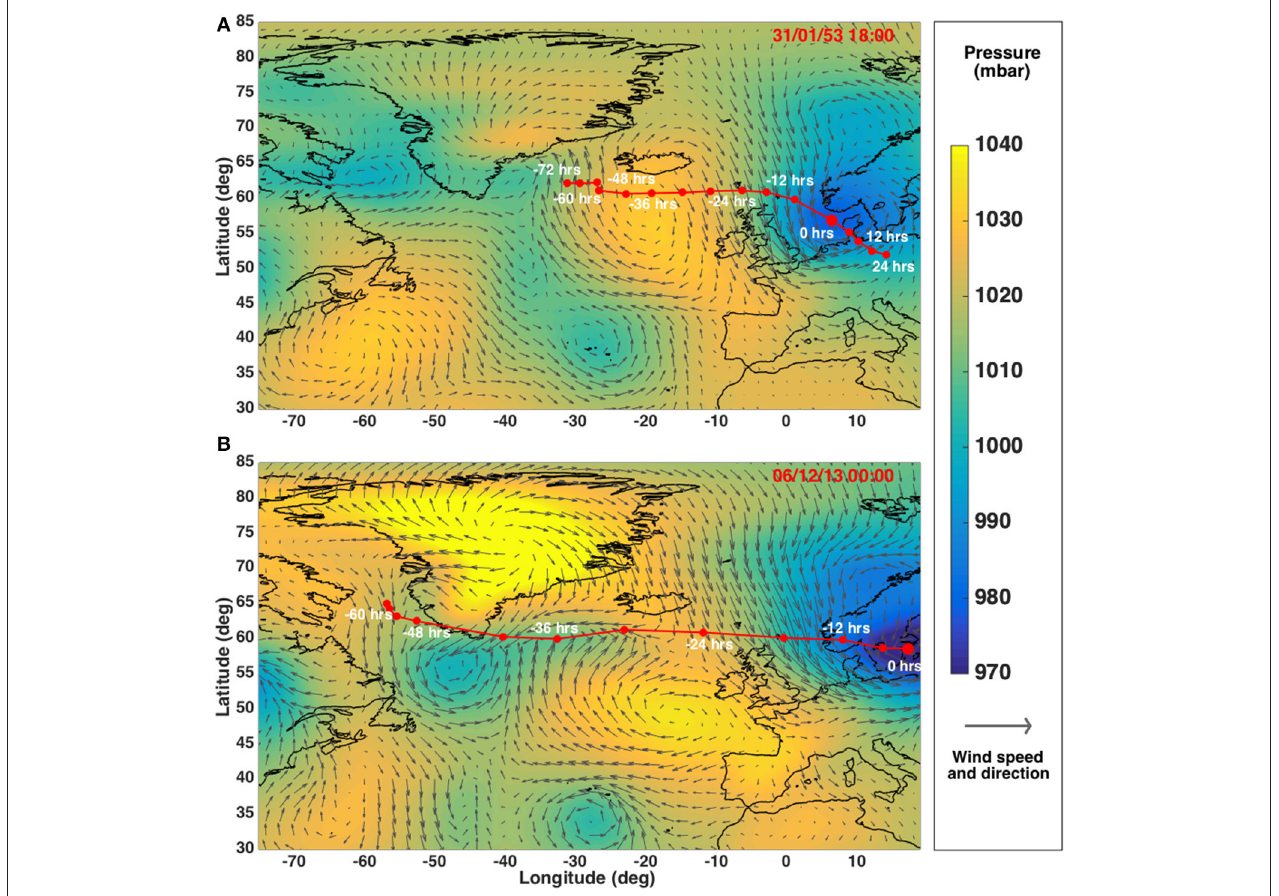
FIGURE 1 | (A) Synopses of storm track and wind-field for the 31 January–1 February 1953 storm, and (B) the 5–6 December 2013 storm.